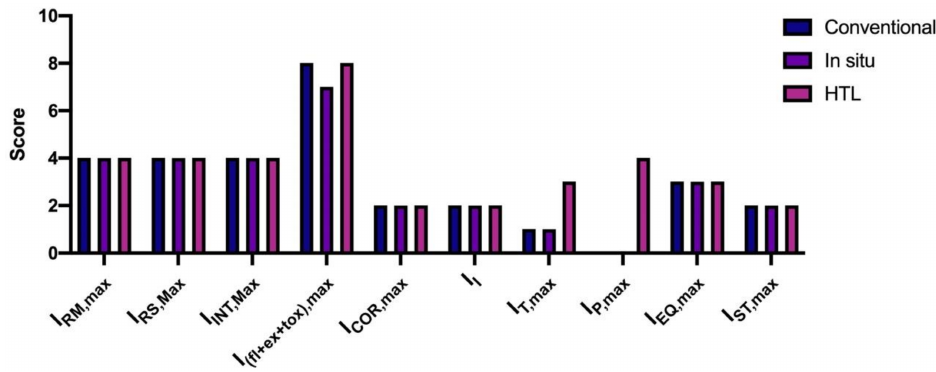
Figure 6. Subindices for chemical and process safety